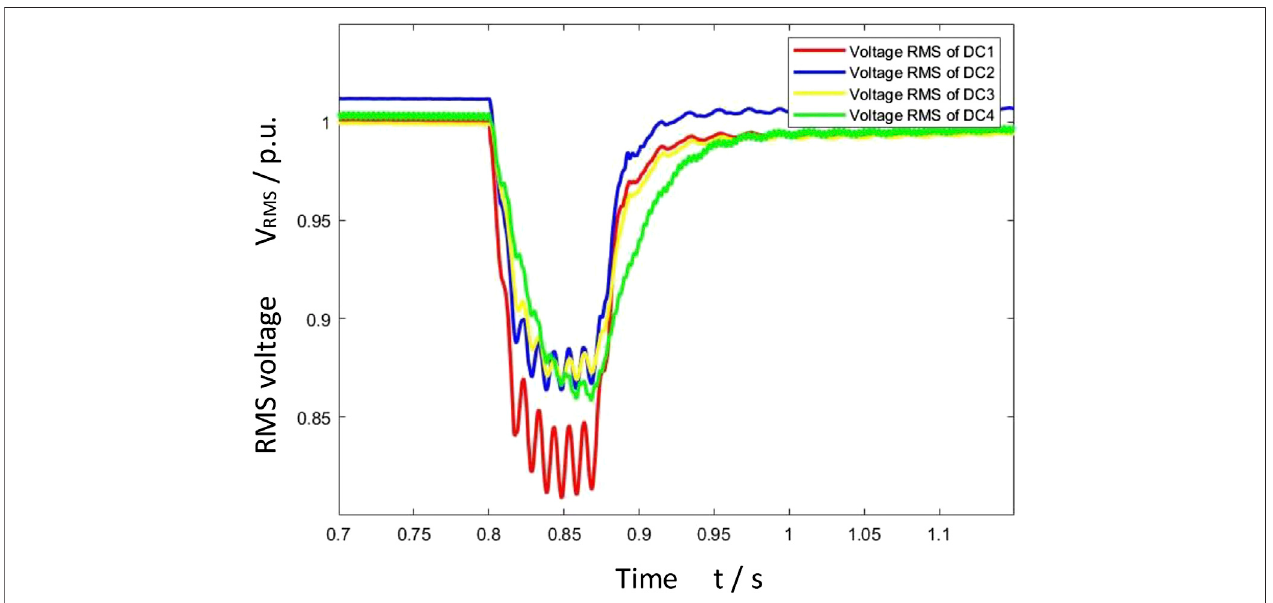
FIGURE 5 | Voltage RMS of four converter buses.